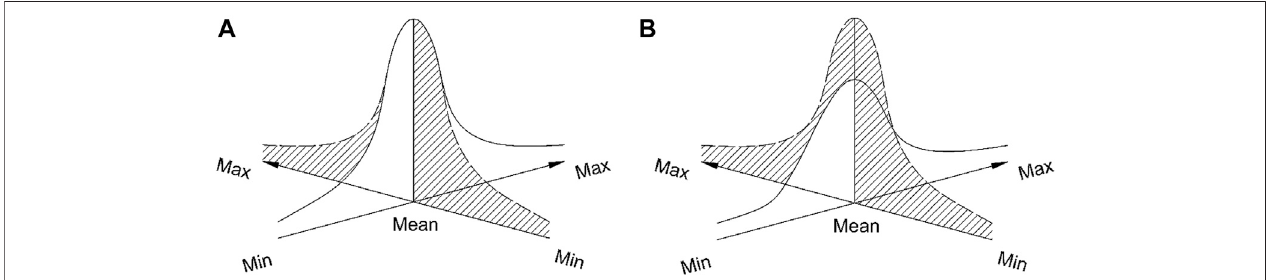
FIGURE 6 | Visualisation of the possible intersection of the novelty processing (white) with the reward processing (striped) distributions in the subjective cognitive space in the case of similar standard deviations (A) and dissimilar standard deviations (B)